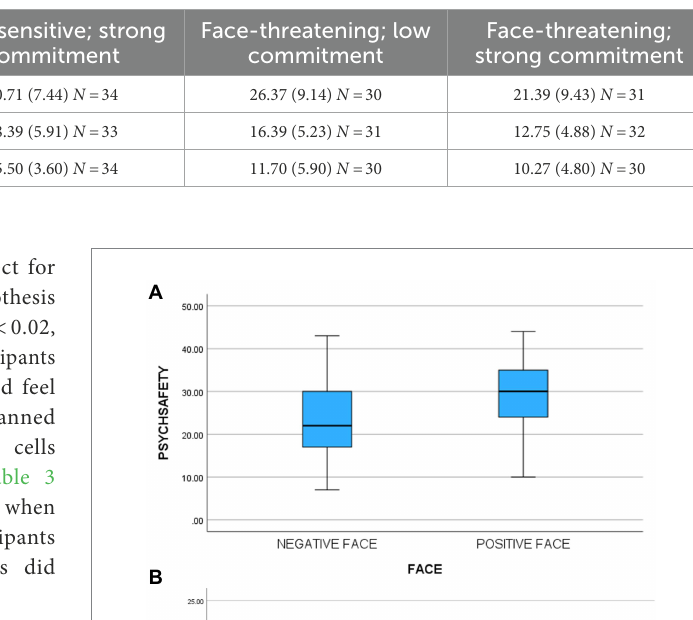
Face-sensitive; strong commitment